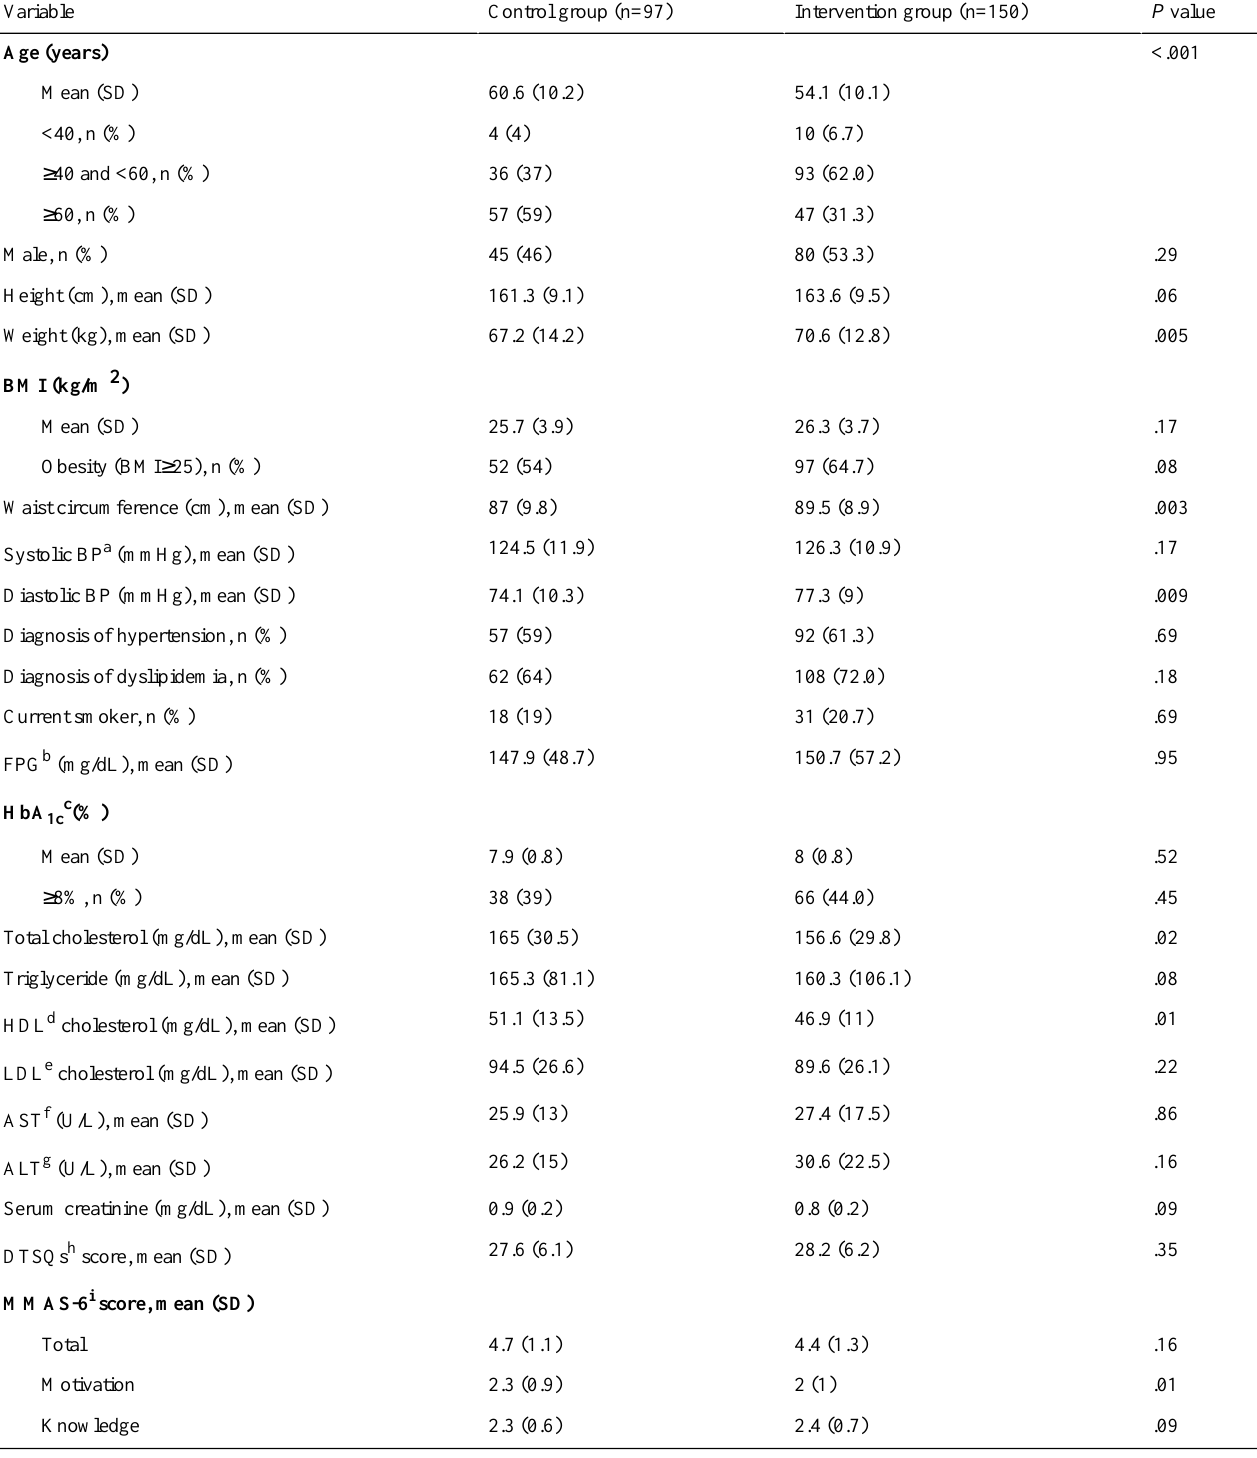
Table 1. Baseline characteristics of study